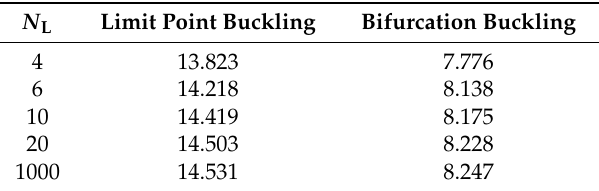
Table 1. Effect of layers number N L on critical buckling load (X-GPLRC, α = 1.5, S / h = 80, W GPL = 0.5%, λ = 8).